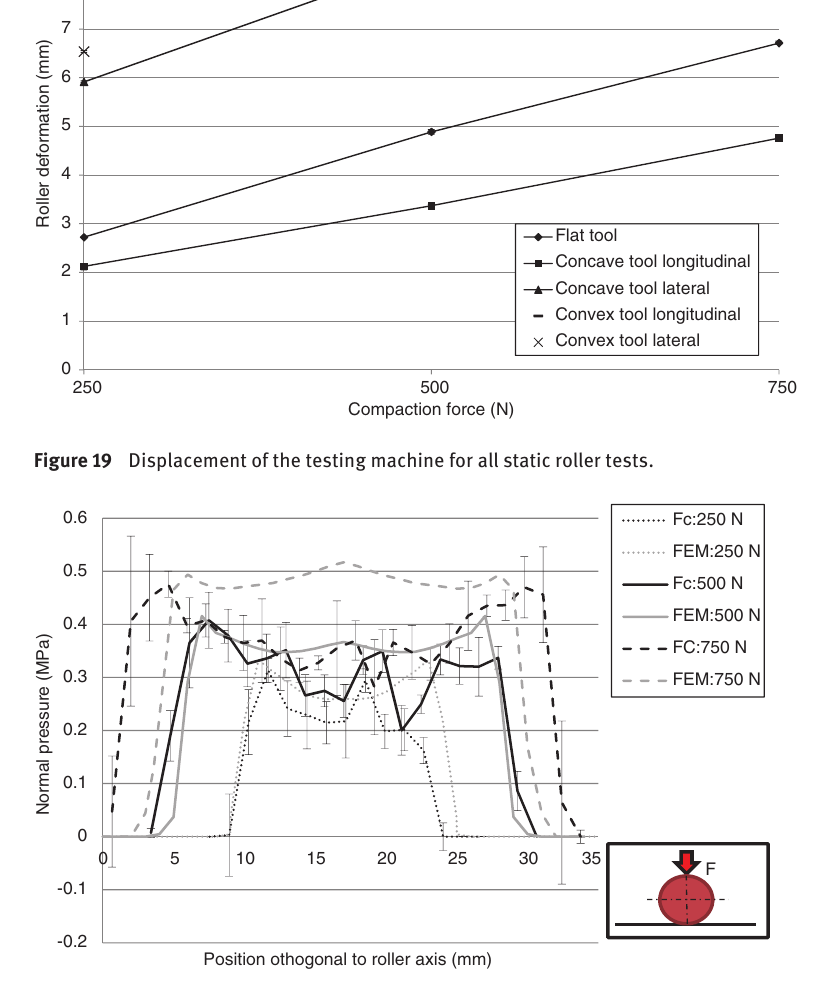
Figure 20 Pressure distribution of the compaction roller on the flat tool orthogonal to roller axis.